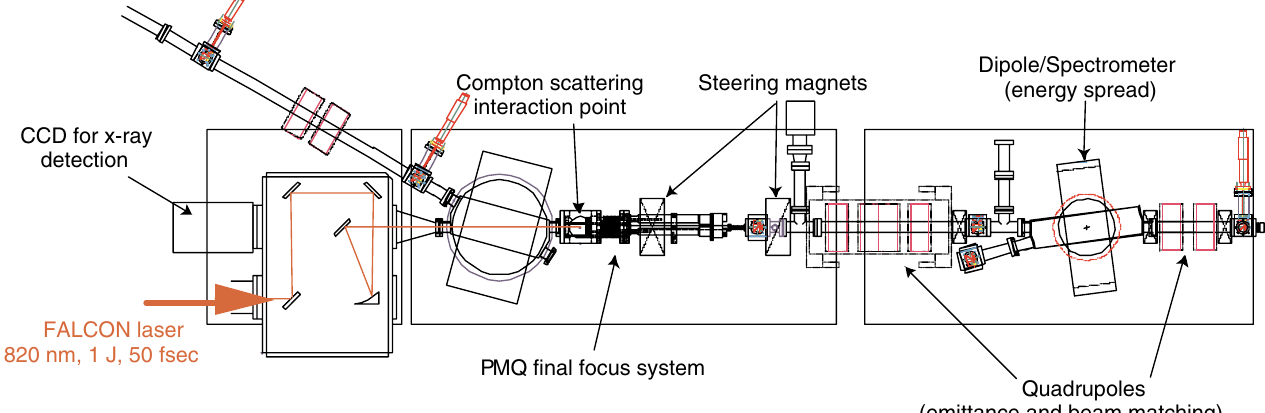
FIG. 17. (Color) Schematic drawing of the PLEIADES interaction beam